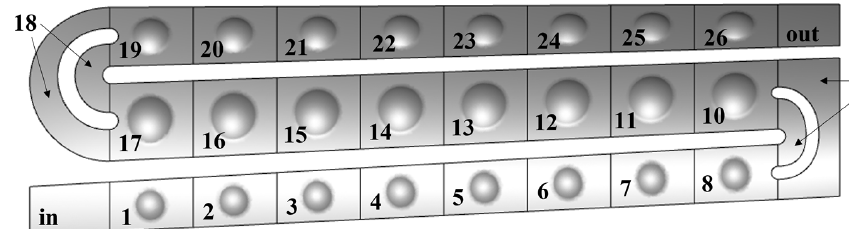
Figure 7. Region division and naming.